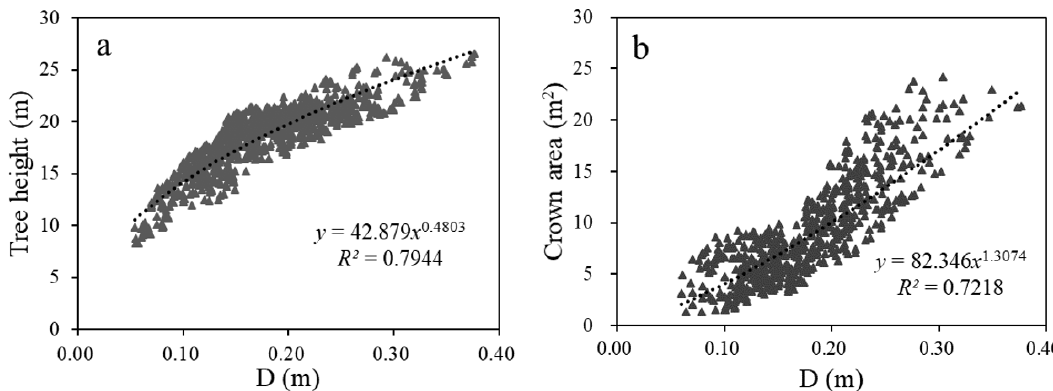
Figure 7. Allometric growth equation of D-tree height ( a ) and D-tree crown area ( b ) based on measured data of the sample plots. Table 4. Table of precision evaluation for annual mean NPP.